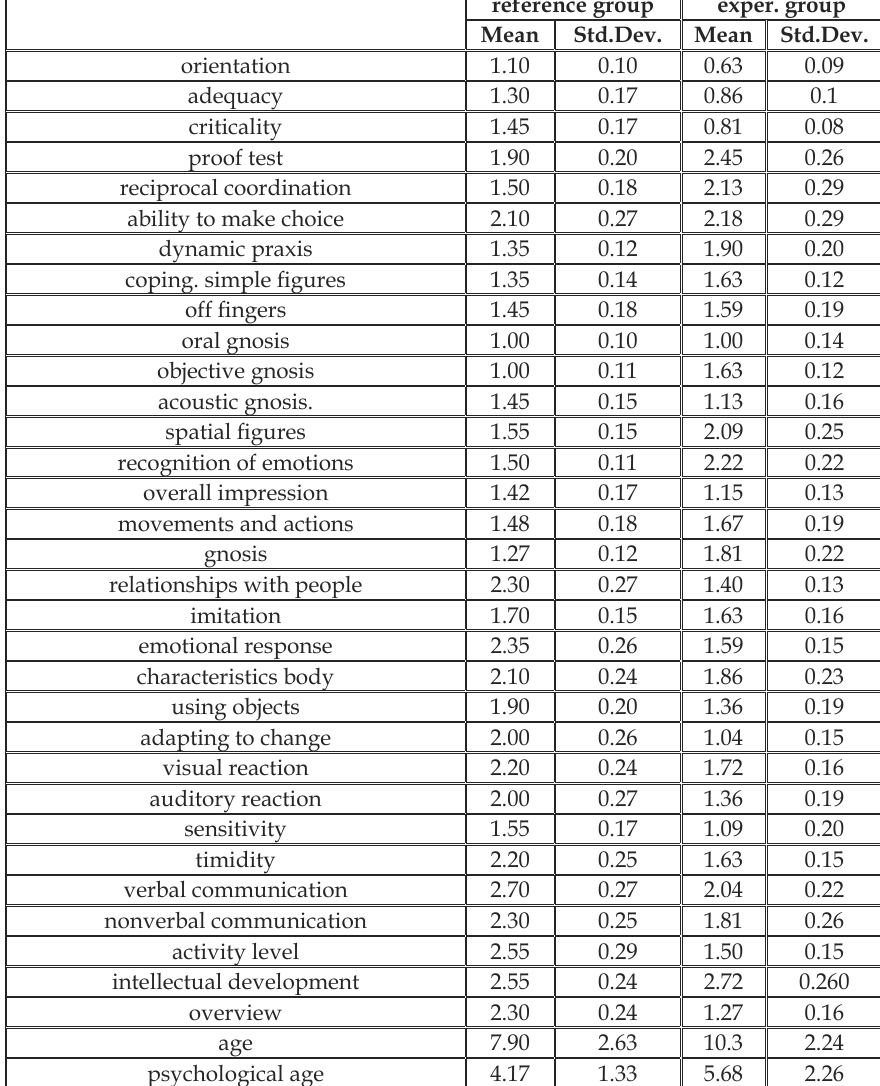
Table 1. A comparison of indeces for two ASD groups (Std.Dev.–standard